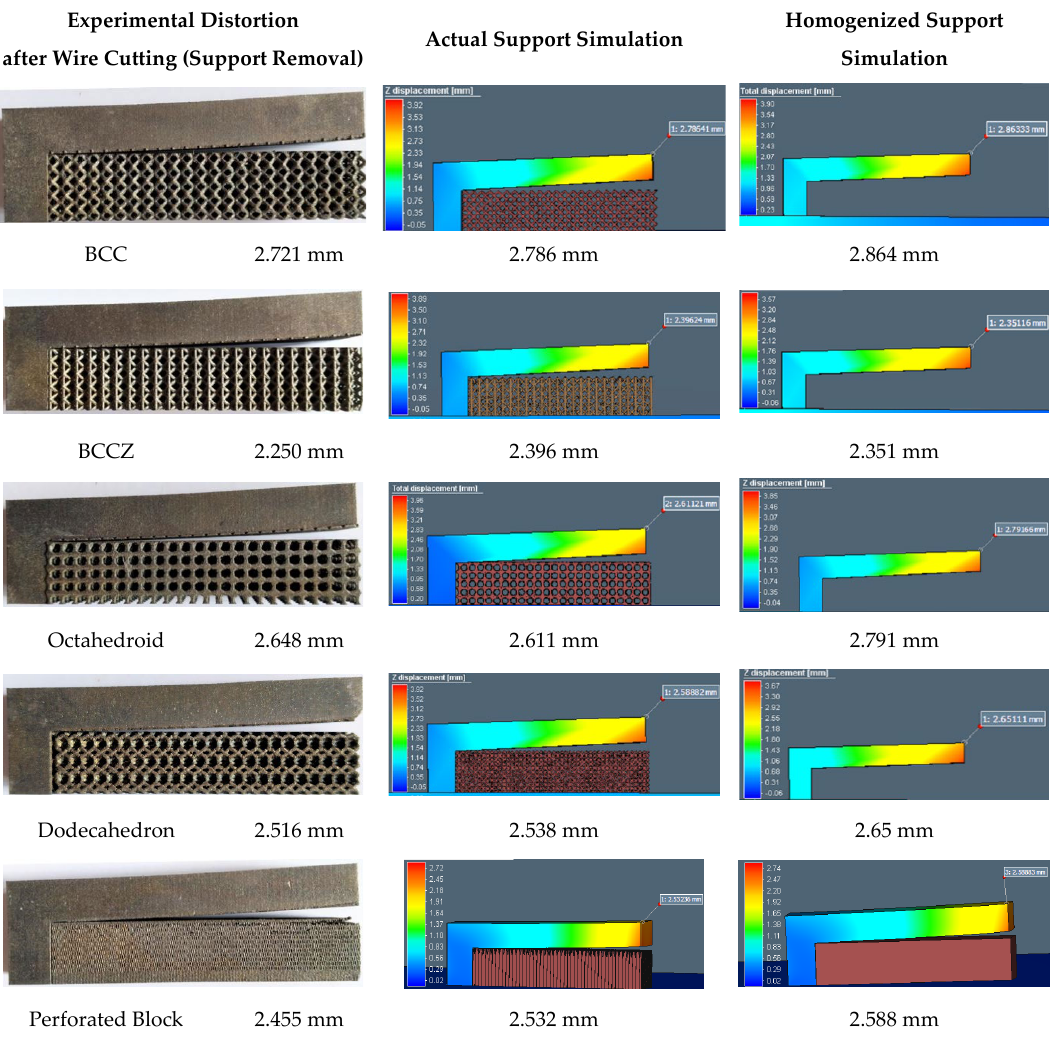
Figure 14. Simulation plots of homogenized and actual support geometry.